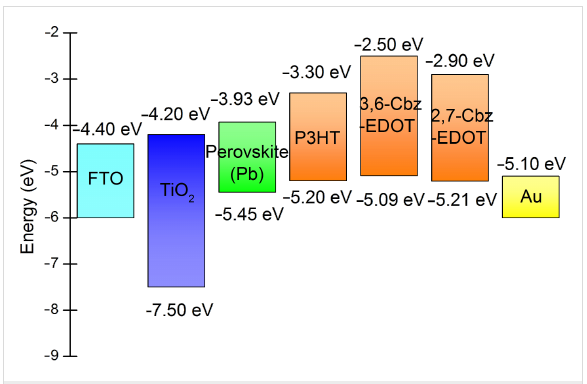
Figure 2: Energy level diagram of PSC components including P3HT, 3,6-Cbz-EDOT, and